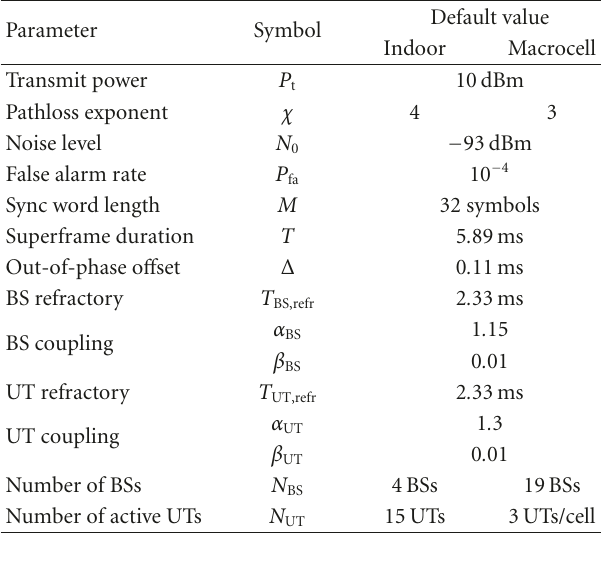
Table 1: Default simulation parameters.